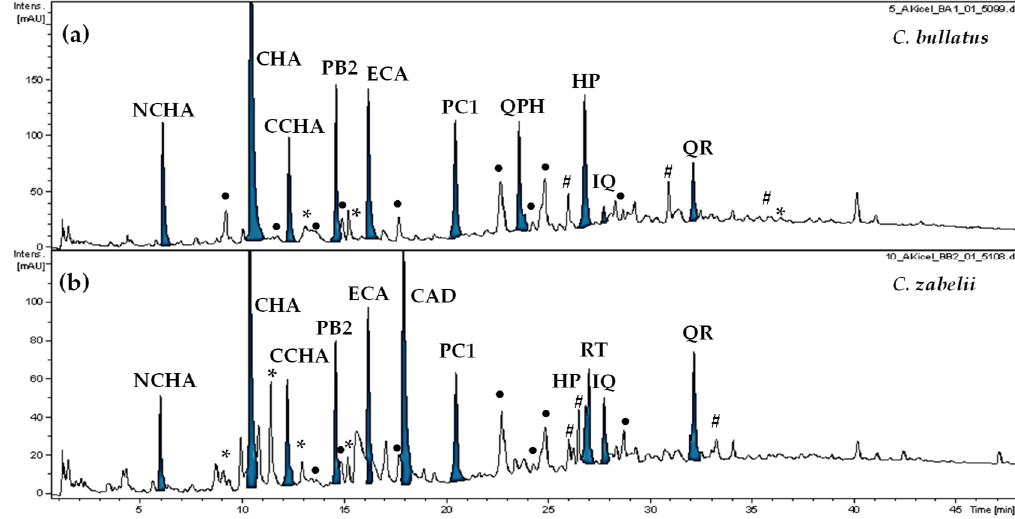
Figure 1. Representative UHPLC-UV chromatograms of the methanol-water (7;3, v / v ) extracts from the leaves of C. bullatus ( a ) and C. zabelii ( b ) at 280 nm. Potential active markers are marked in blue. NCHA, neochlorogenic acid (3– O -ca ff eoylquinic acid); CHA, chlorogenic acid (5– O -ca ff eoylquinic acid); CCHA, cryptochlorogenic acid (4– O -ca ff eoylquinic acid); CAD, ca ff eic acid derivative; ECA, (–)-epicatechin; PB2, procyanidin B2; PC1 procyanidin C1; QPH, quercetin pentoside-hexoside; RT, rutin; HP, hyperoside; IQ, isoquercitrin; QR, quercitrin. Other identified constituents are labeled with the appropriate symbol depending on the phytochemical group they belong to: • , B-type procyanidins; * , ca ff eic and p -coumaric acids derivatives; # , quercetin glycosides. For details of compounds (cid:48) identification, see Supplementary Materials, Figure S1 and Table